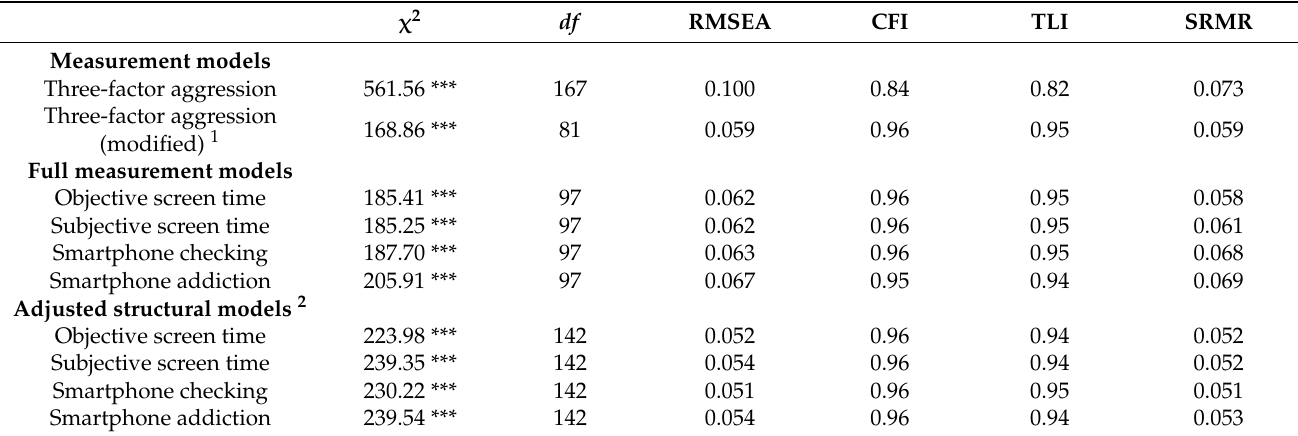
Table 3. Model Fit Indices for Measurement and Structural Models.